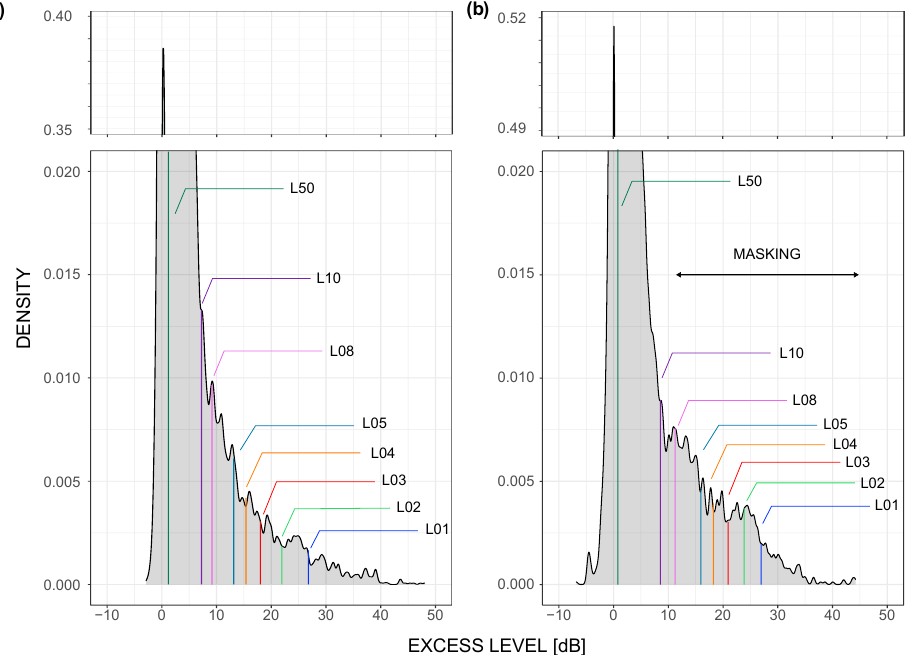
Figure 14. Weekly PDFs of 500 Hz TOB sound excess levels recorded in Moonsund for two periods in ( a ) summer and ( b ) winter. The risk of masking occurs less than 8% of the time when it exceeds the estimated natural ambient sound by 12 dB. The excess level of 0 dB means that the RL coincided with the estimated natural ambient sound